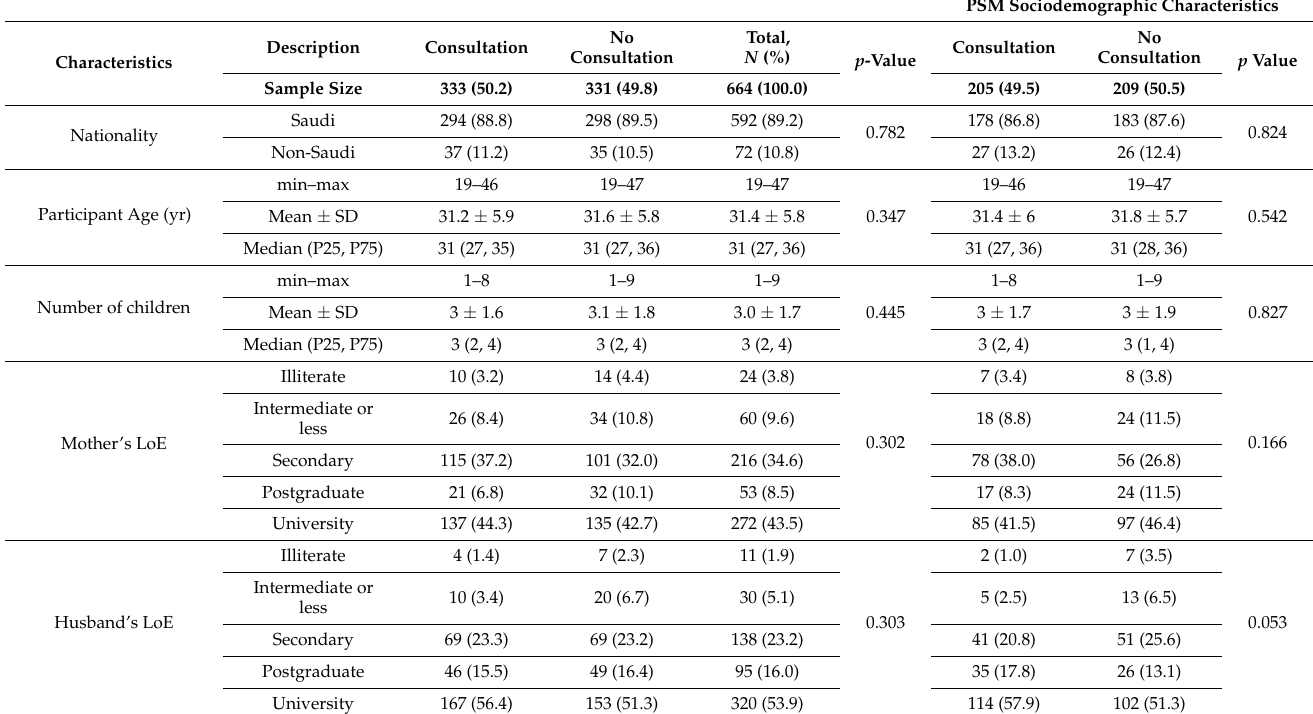
Table 1. Sociodemographic